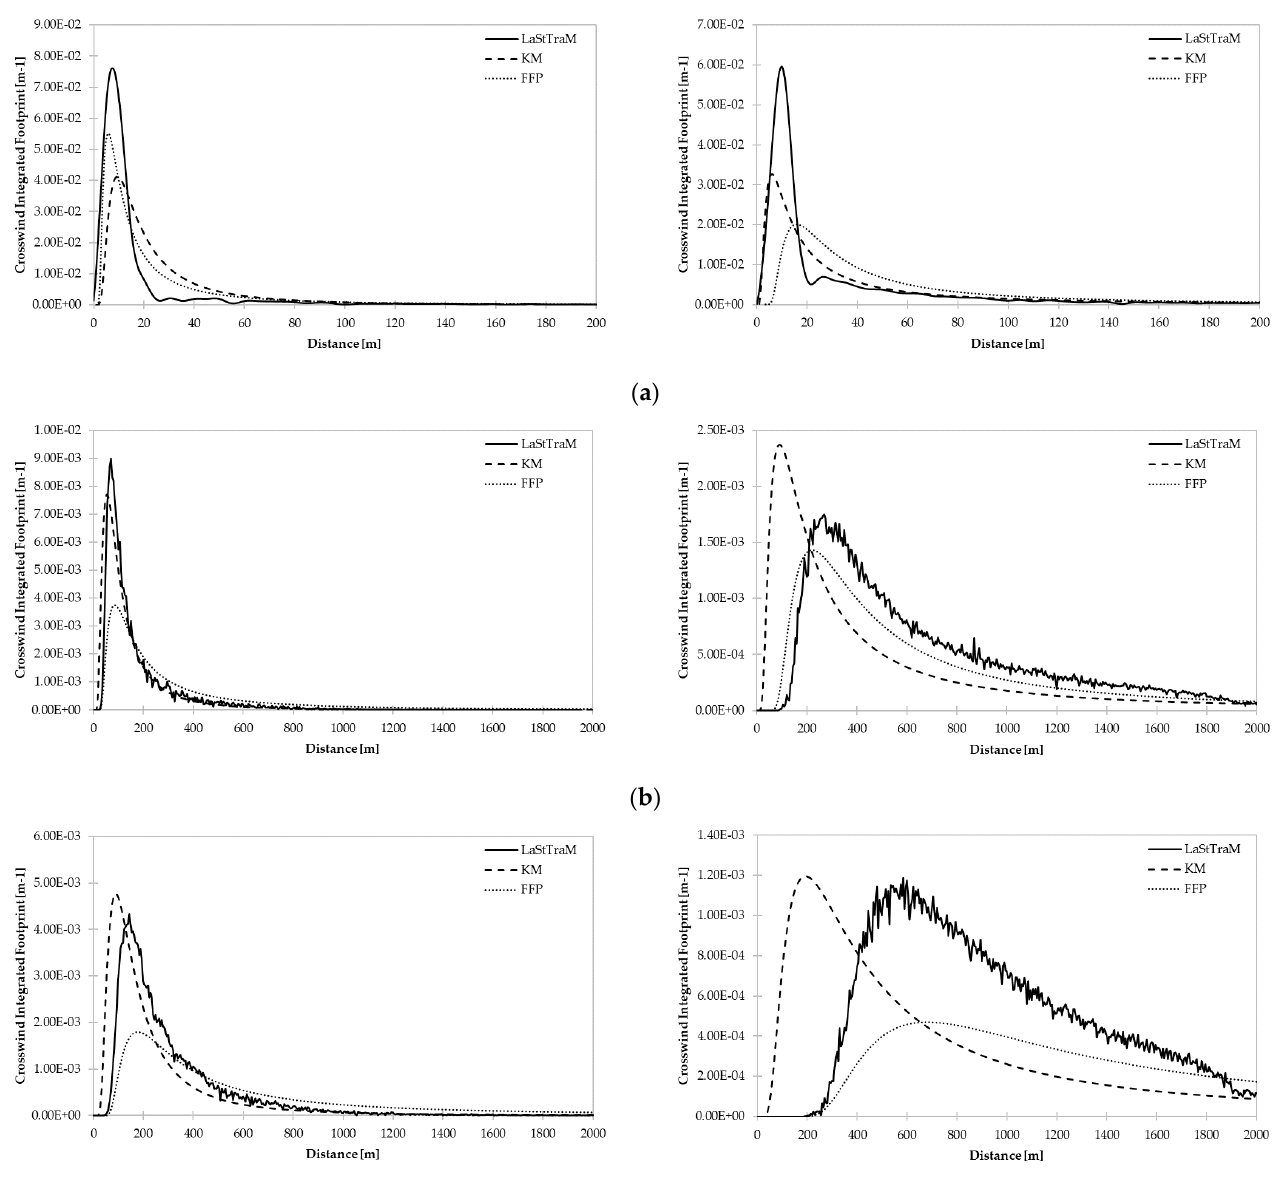
Figure 6. Comparison of crosswind integrated footprints of LaStTraM, FFP and K–M for different detector heights in a unstable (left column) and stable (right column) case. ( a ) Height of detector 3 m above ground; ( b ) height of detector 20 m above ground; ( c ) height of detector 40 m above ground.